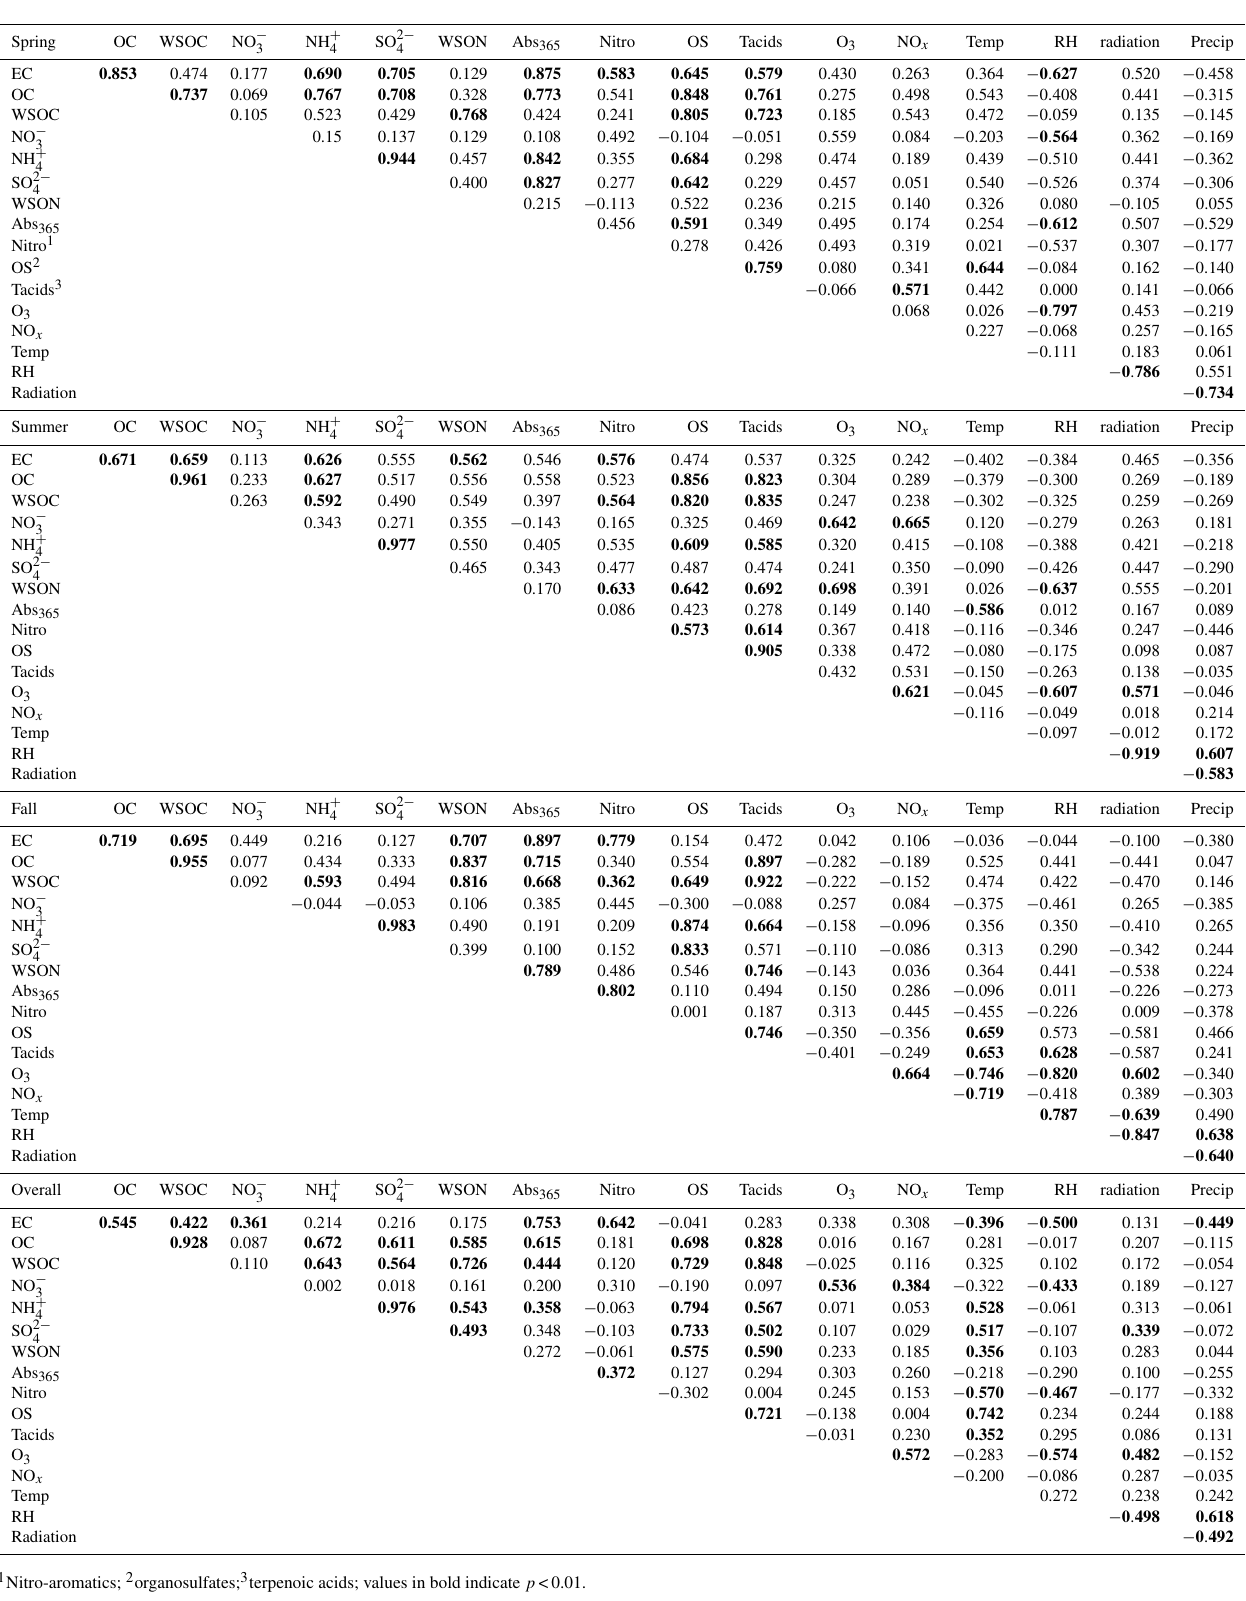
Table 2. Spearman rank correlation coefficients among measured species and meteorological variables by season. Nitro-aromatics (Nitro), Organosulfates (OS), and terpenoic acids (Tacids) represent group summed concentrations.